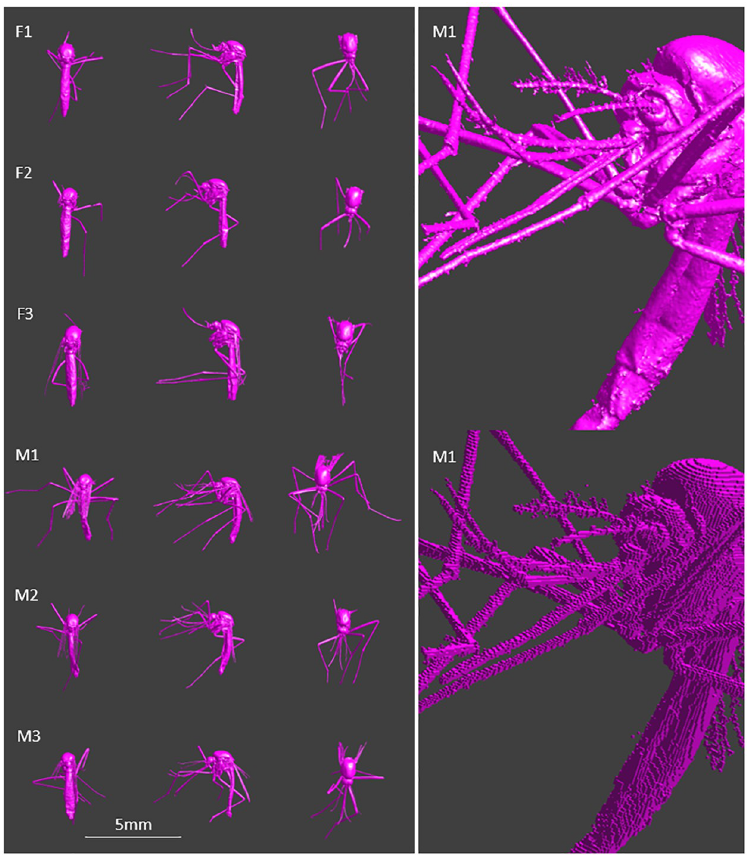
Fig 2. 3D models of mosquitoes. Left: Overview of models used in simulations (F: females, M: males). Left to right: Back, side and top view. Right: Mosquito M1 as triangulated model (top) and voxelated model (bottom) with Voxel size 25 μ m.